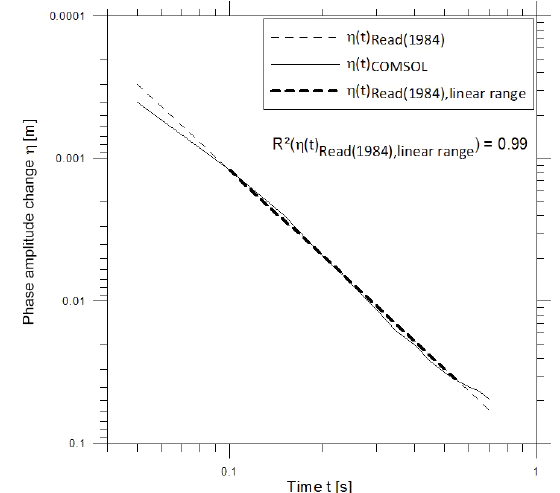
Figure 4. Interface amplitude change η of Rayleigh-Taylor insta- bility over time. The η COMSOL represents the COMSOL modelling result as a grey line while η Read represents the analytical solution for the late nonlinear to early turbulent RT regime as a dashed line. The bold dashed line visualizes the representative part of the ana- lytical